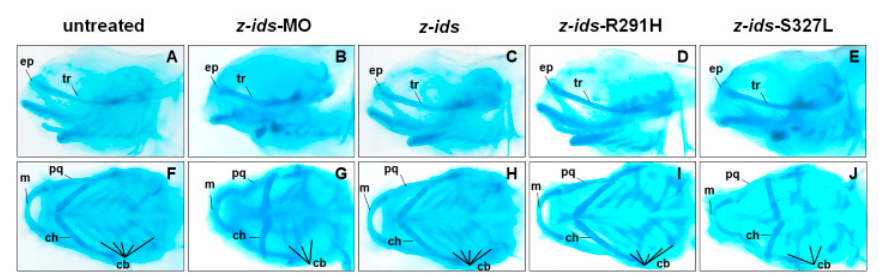
Figure 5. Defective phenotypes of head cartilage during the development of zebrafish embryos injected with di ff erent mutant forms of z- ids mRNA and z- ids -MO. Using Alcian blue staining to detect head cartilage development in zebrafish embryos at 5 dpf. Embryos were injected with the antisense morpholino oligonucleotides (z- ids -MO) and di ff erent mutant forms of z- ids mRNAs, as indicated. ( A – E ) Lateral view; ( F – J ) Ventral view. ( A , F ) Untreated control embryos; ( B , G ) z- ids -MO-, ( C , H ) z- ids -, ( D , I ) z- ids -R291H-, and ( E , J ) z- ids- S327L-mRNA-injected embryos. cb, ceratobranchial;